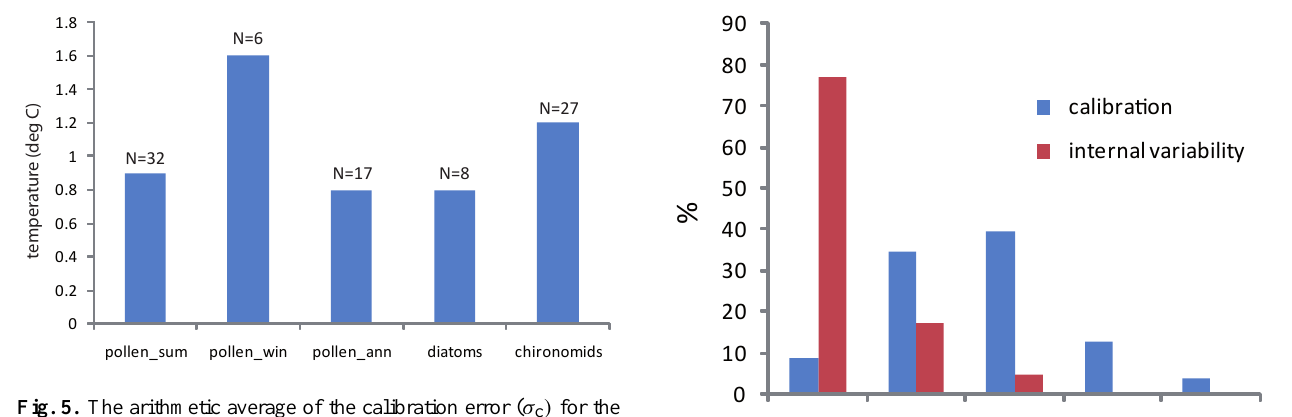
Fig. 5. The arithmetic average of the calibration error ( σ c ) for the most common proxies. N =number of reconstructions.